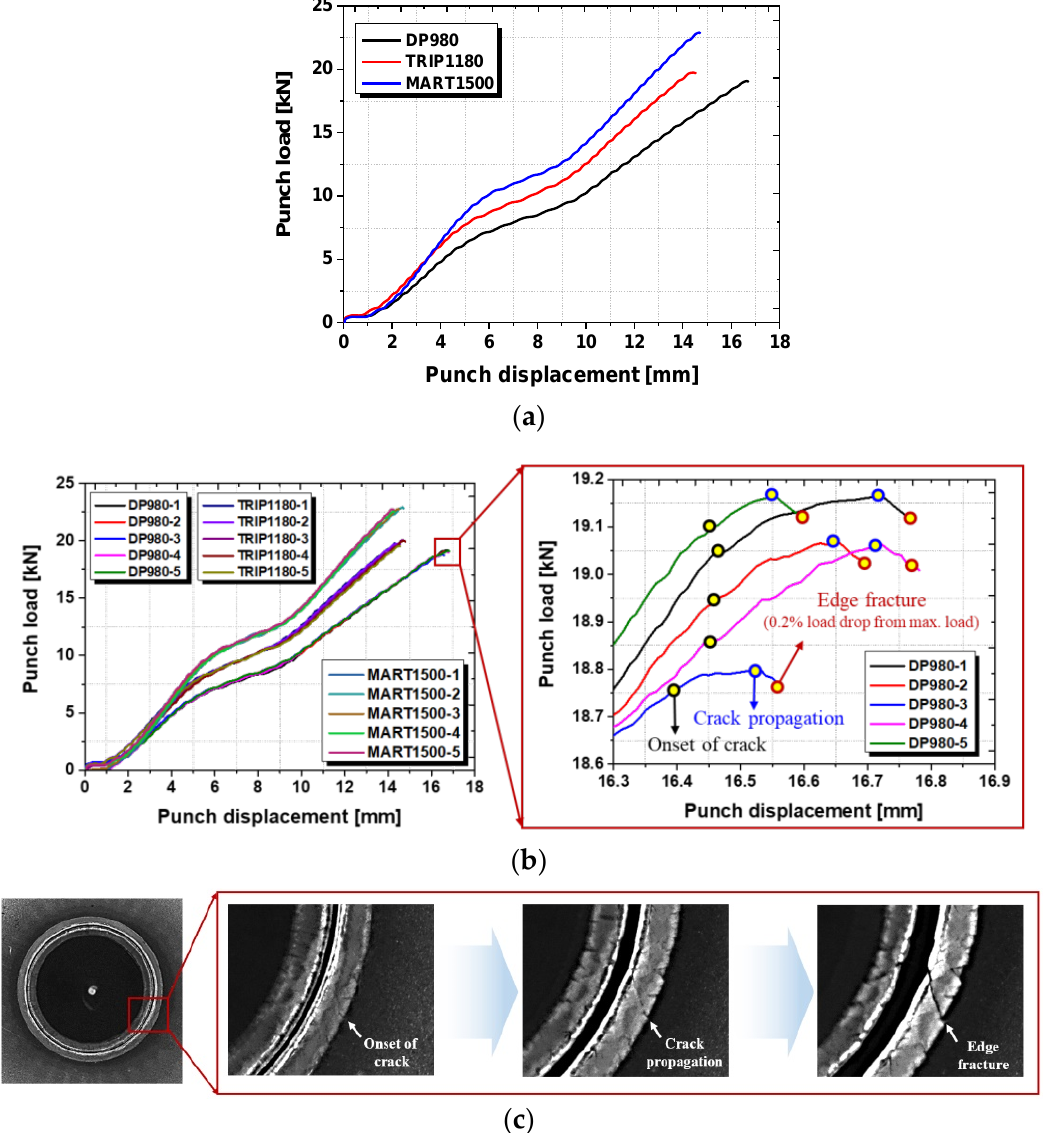
Figure 7. Punch load–displacement analysis with images by live video: ( a ) punch-load displacement curve in terms of AHSS sheets; ( b ) classification of crack formation in punch-load displacement curve; ( c ) enlarged test image for onset of crack, crack propagation and edge fracture.